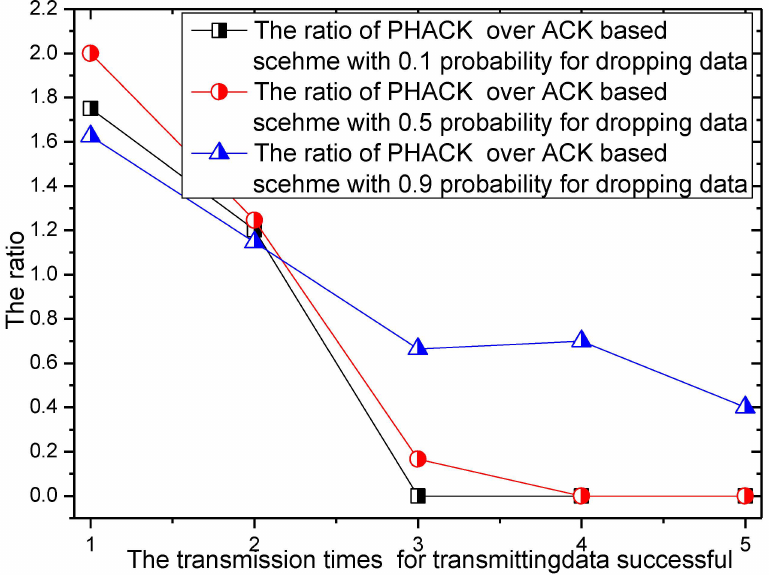
Figure 17. The ratio of PHACK and the ACK-based scheme with different rates for the dropping of